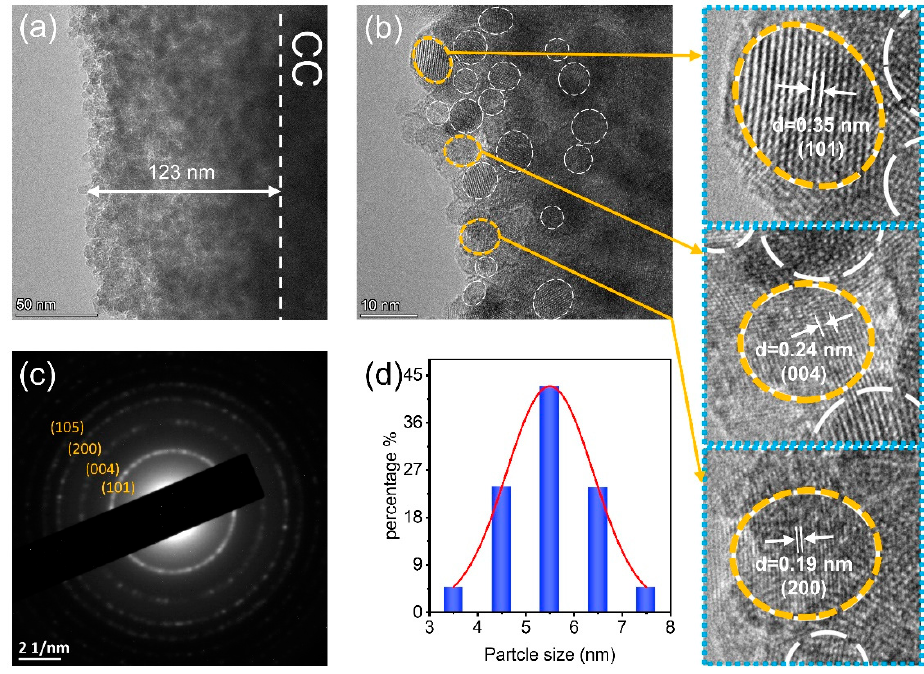
Figure 3. TEM ( a ), HR-TEM ( b ), SAED ( c ) images, and ( d ) particle size distribution of TQDs/CC